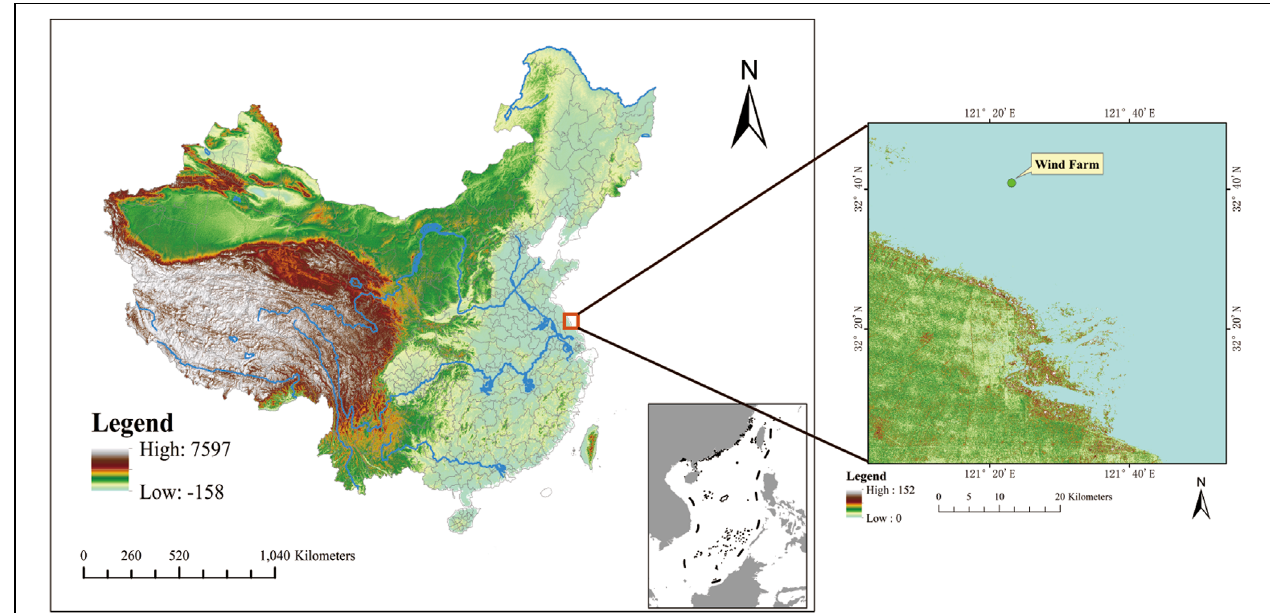
FIGURE 1 | The location of the target wind farm.